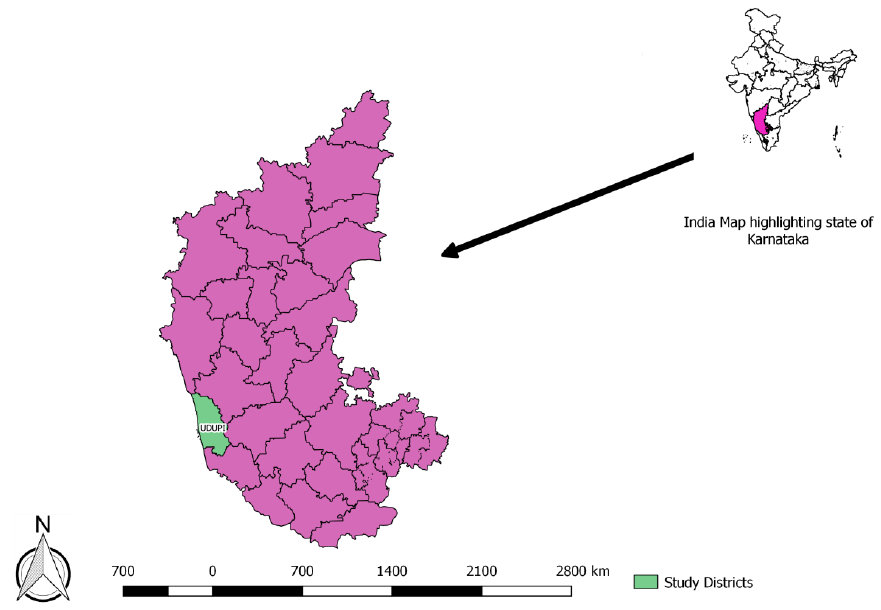
Figure 1. Depicting the Udupi district, Karnataka, Figure 1. depicting the Udupi district, Karnataka, India.